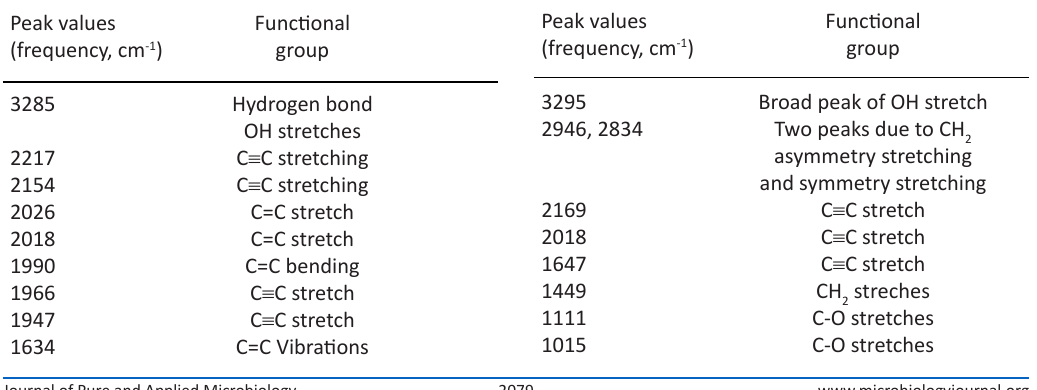
Fig. 1. IR spectrum of aqueous extracts of L. nobilis Table 6. FTIR spectrum of the aqueous extracts of L. nobilis leaves